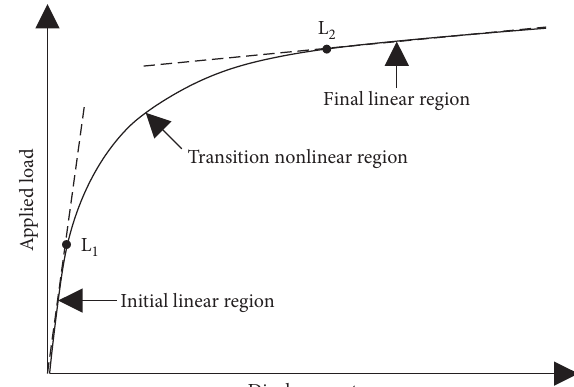
Figure 6: Sections of load-displacement curve for the L method